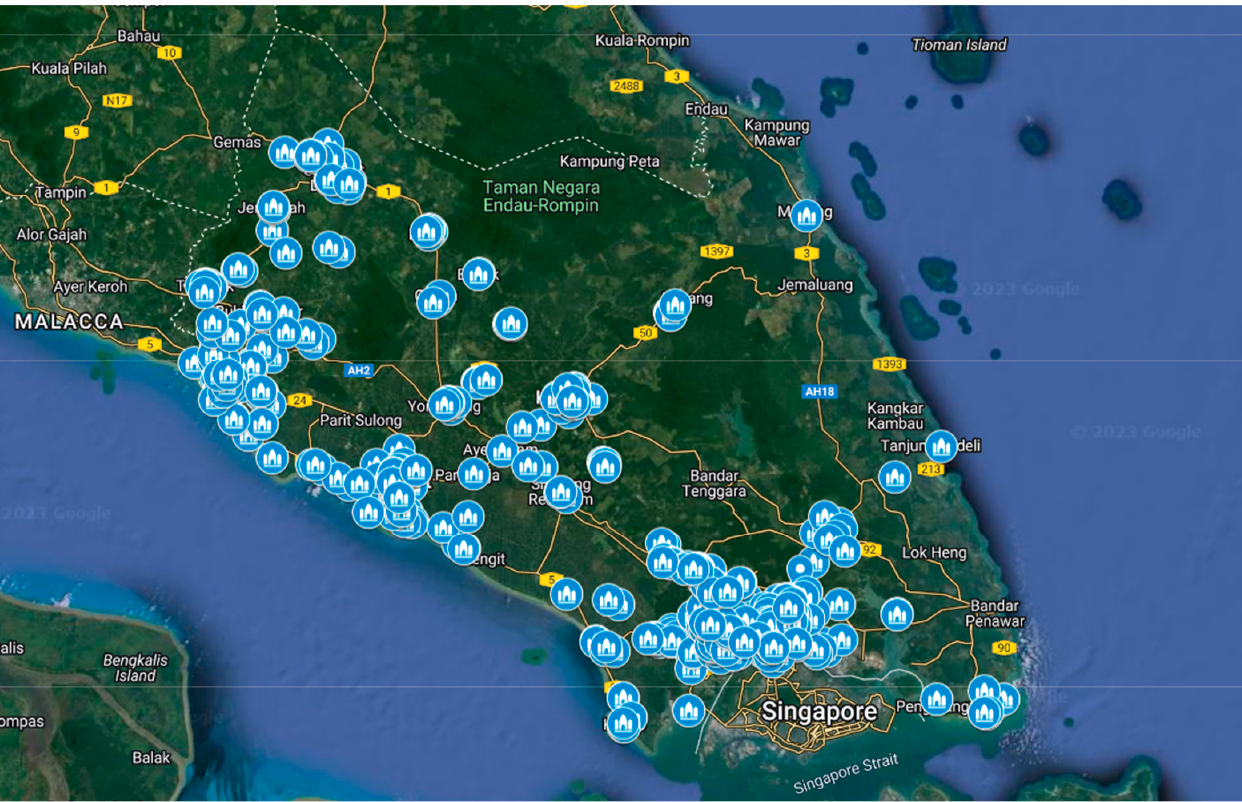
Figure 1. Johor Temples Distribution Map From